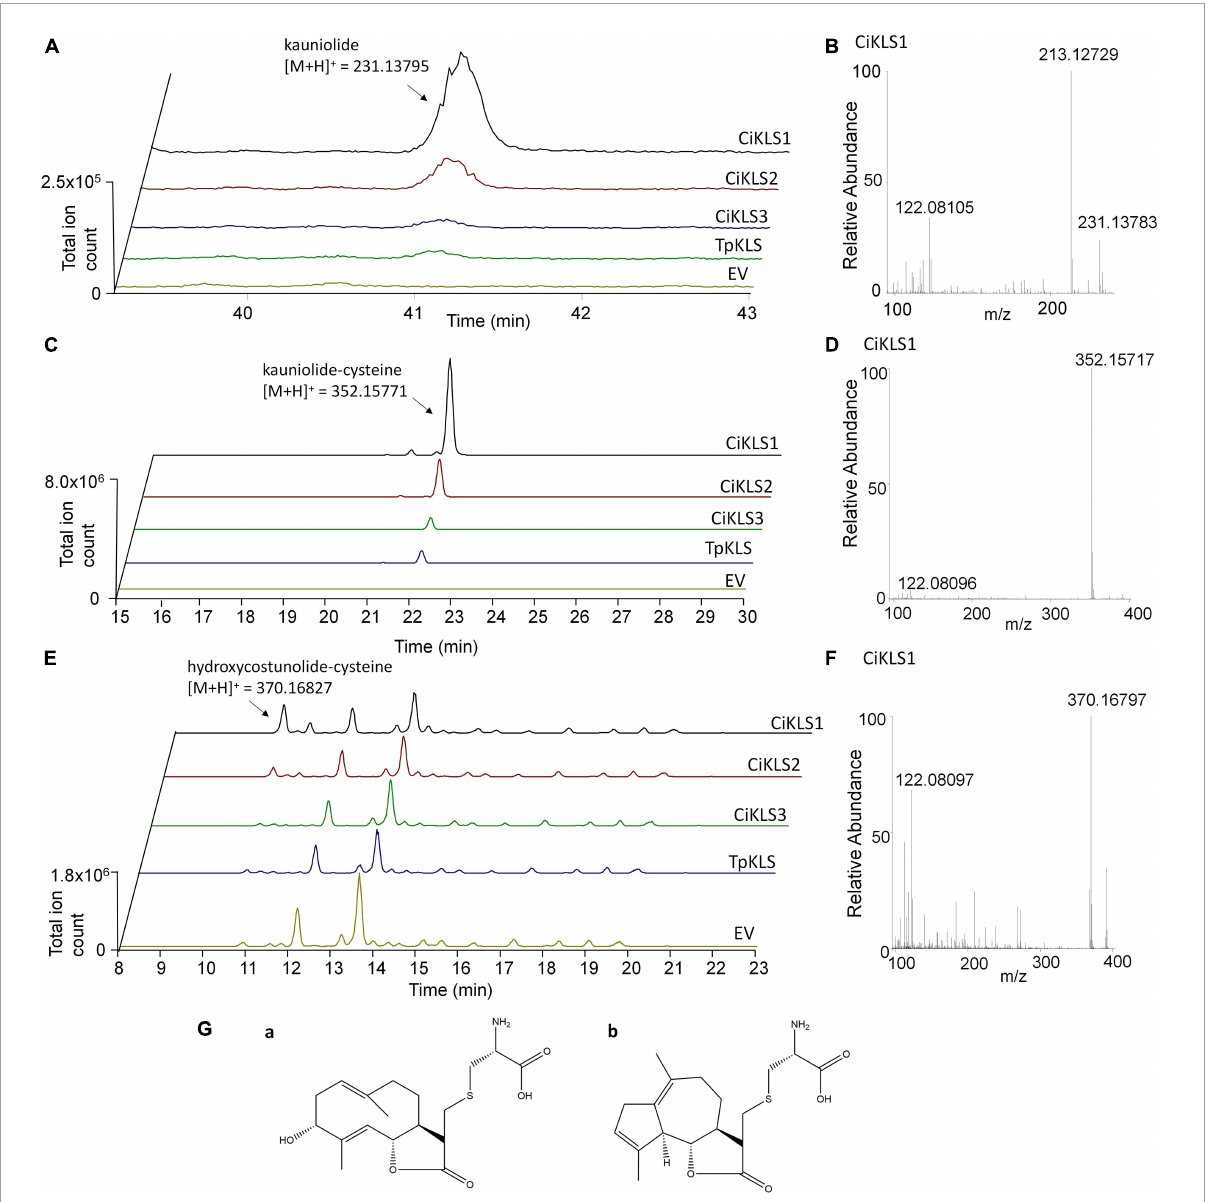
FIGURE3 Analysis of in vitro enzyme activity of CiKLS enzymes in yeast microsome assays. (A) LC-Orbitrap-FTMS chromatograms are shown at m/z = 231.13795 typical for kauniolide (5 ppm, positive ionization mode) for enzyme assay using microsomes expressing CiKLS1, CiKLS2, CiKLS3, and TpKLS incubated with costunolide. Microsomes from a yeast strain containing empty pYEDP60 vector (EV) are used as control. (B) Mass spectrum of kauniolide produced by CiKLS1. (C) LC-Orbitrap-FTMS chromatograms are shown at m/z = 352.15771 typical for kauniolide-cysteine (5 ppm, positive ionization mode) for enzyme assay using microsomes expressing CiKLS1, CiKLS2, CiKLS3, and TpKLS incubated with costunolide followed by cysteine conjugation. Microsomes from a yeast strain containing empty pYEDP60 vector (EV) are used as control. (D) Mass spectrum of kauniolide-cysteine produced by CiKLS1. (E) LC-Orbitrap-FTMS chromatograms are shown at m/z = 370.16827 typical for 3 α -hydroxycostunolide-cysteine (5 ppm, positive ionization mode) for enzyme assays with CiKLS1, CiKLS2, CiKLS3, and TpKLS incubated with costunolide followed by cysteine conjugation. Microsomes from a yeast strain containing empty pYEDP60 vector (EV) are used as control. (F) Mass spectrum of 3 α -hydroxycostunolide-cysteine produced by CiKLS1. (G) Presumed molecular structure of 3 α -hydroxycostunolide-cysteine (a) and kauniolide-cysteine (b).